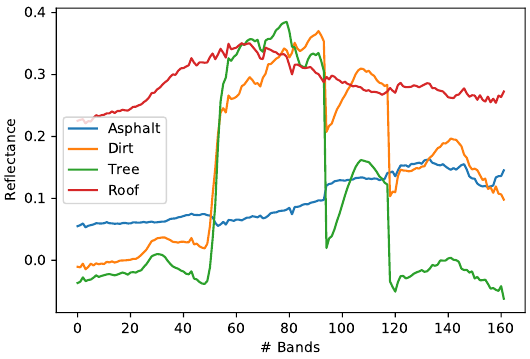
Figure 10. Urban dataset endmembers.